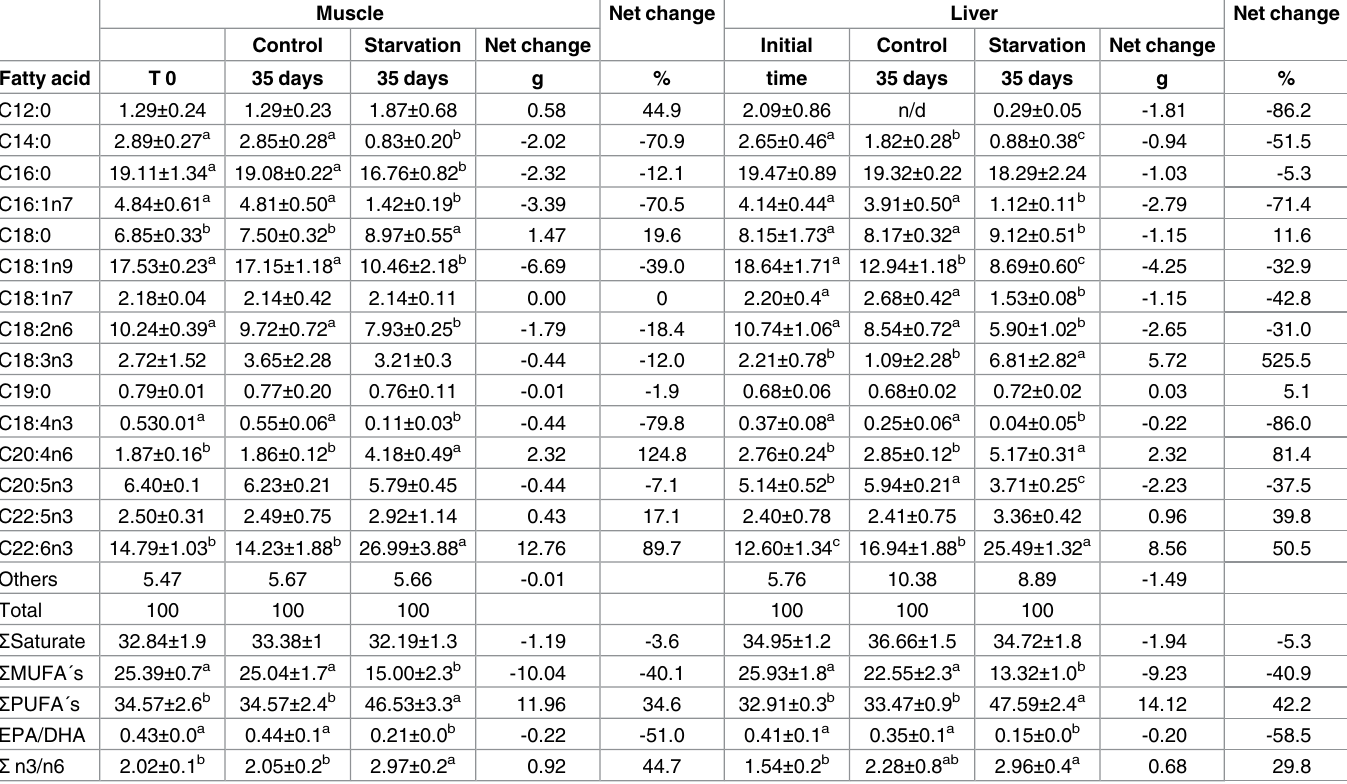
Table 3. Fatty acids content in muscle and liver tissues (g/ 100g tissue) and net change (g and percentage) of S . lalandi after 35 days of starvation. Net change per fatty acids was calculatedbased on the total initial amount and that after 35 days of starvation. Muscle Net change Liver Net change Control Starvation Net change Initial Control Starvation Net change